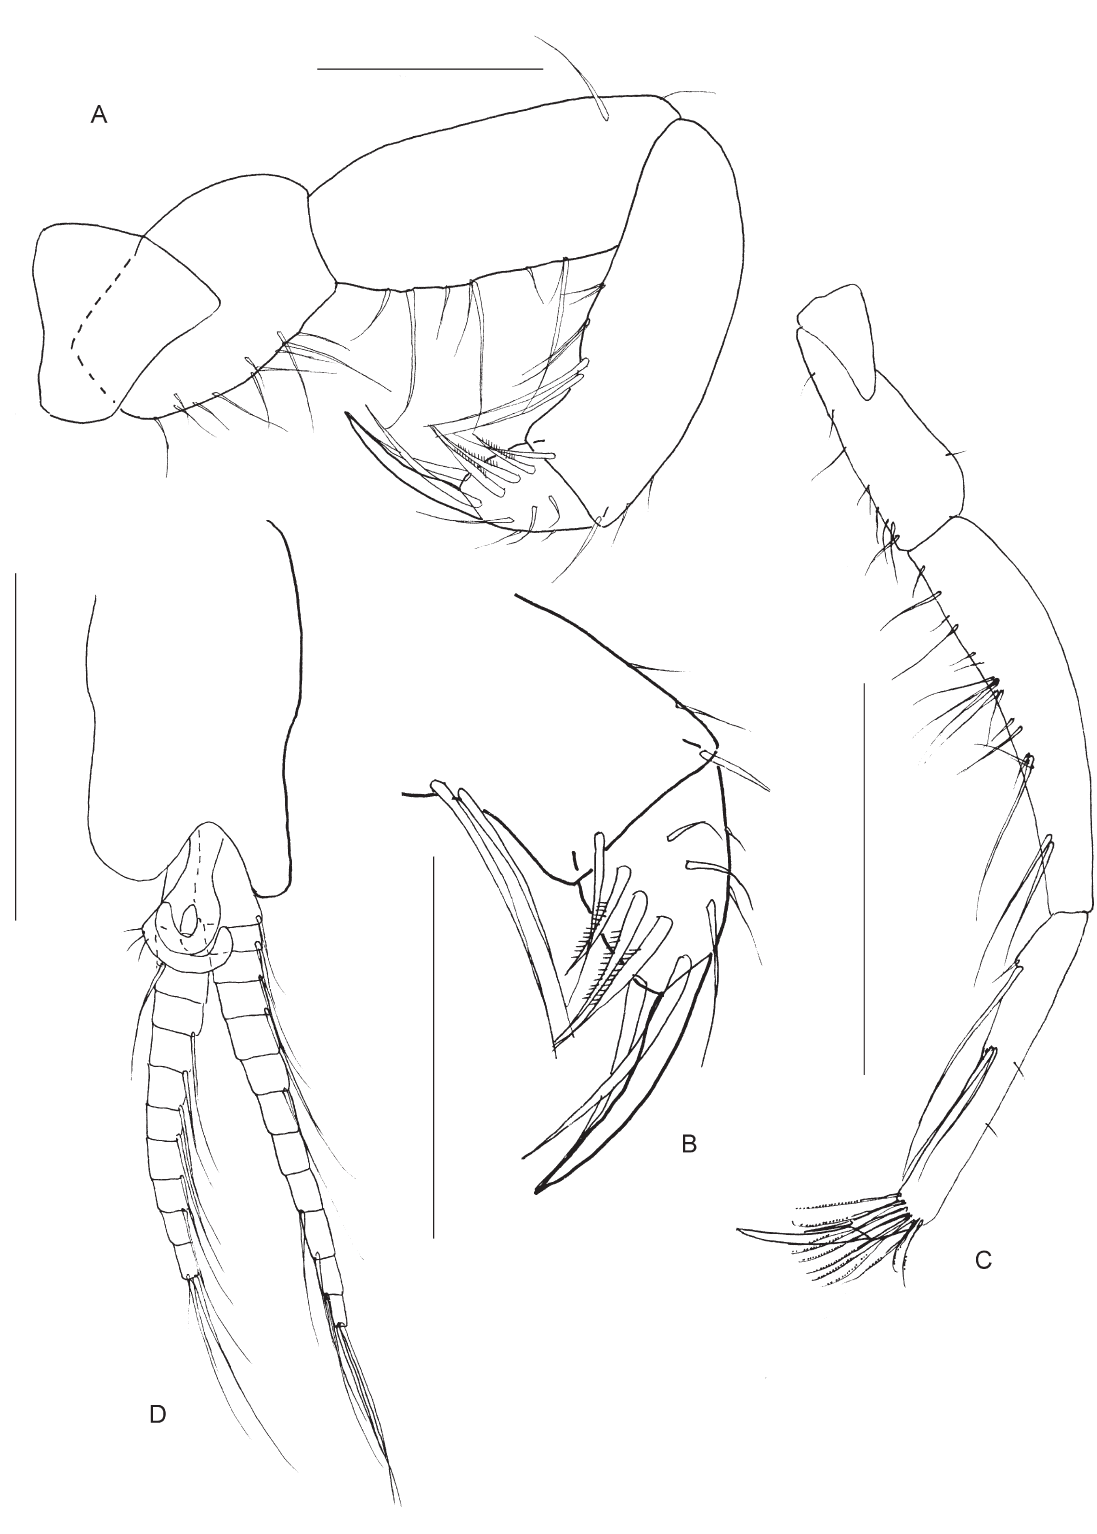
Fig. 31. Siriella vincenti W.M. Tattersall, 1927, syntypes, Gulf of St. Vincent, South Australia, Australia. A . Maxilliped 2 endopod, posterior view. B . Distal part of maxilliped 2 endopod, posterior view. C . Pereopod 1 endopod, posterior view. D . Pleopod 4, posterior view. A–C = ♀, length 7.5 mm; D = ♂, length 7.5 mm. Scale bars: A, C–D = 0.5 mm; B = 0.25